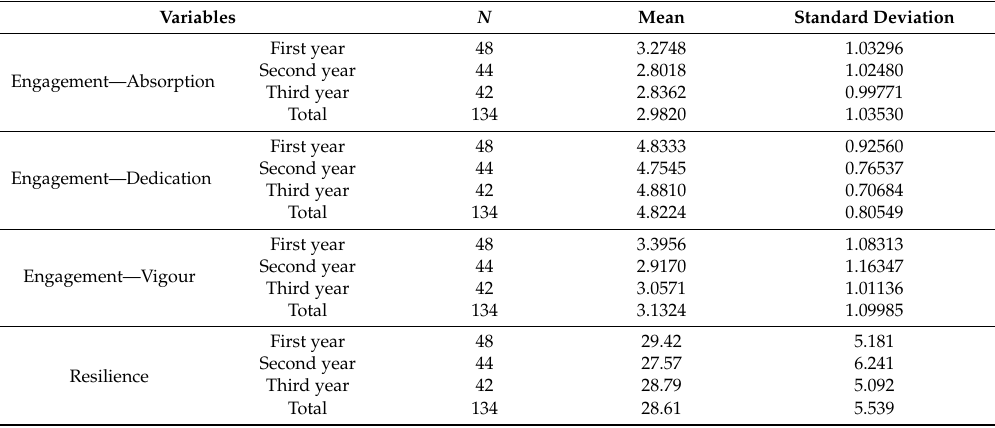
Table 3. Descriptive results of students’ engagement and